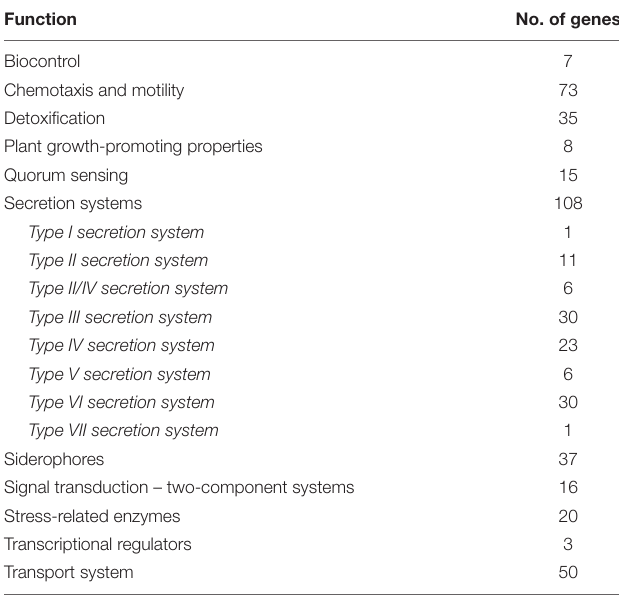
TABLE 1 | List of genes related to plant association, plant growth promotion, and biocontrol identified in the genome of Pseudomonas syringae strain 260-02.